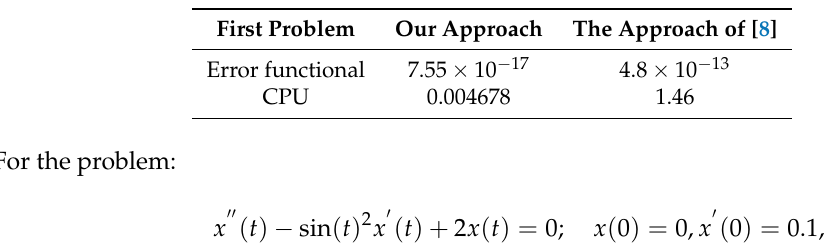
Table 1. Comparison of our approach using the implicit Euler method and the approach proposed in